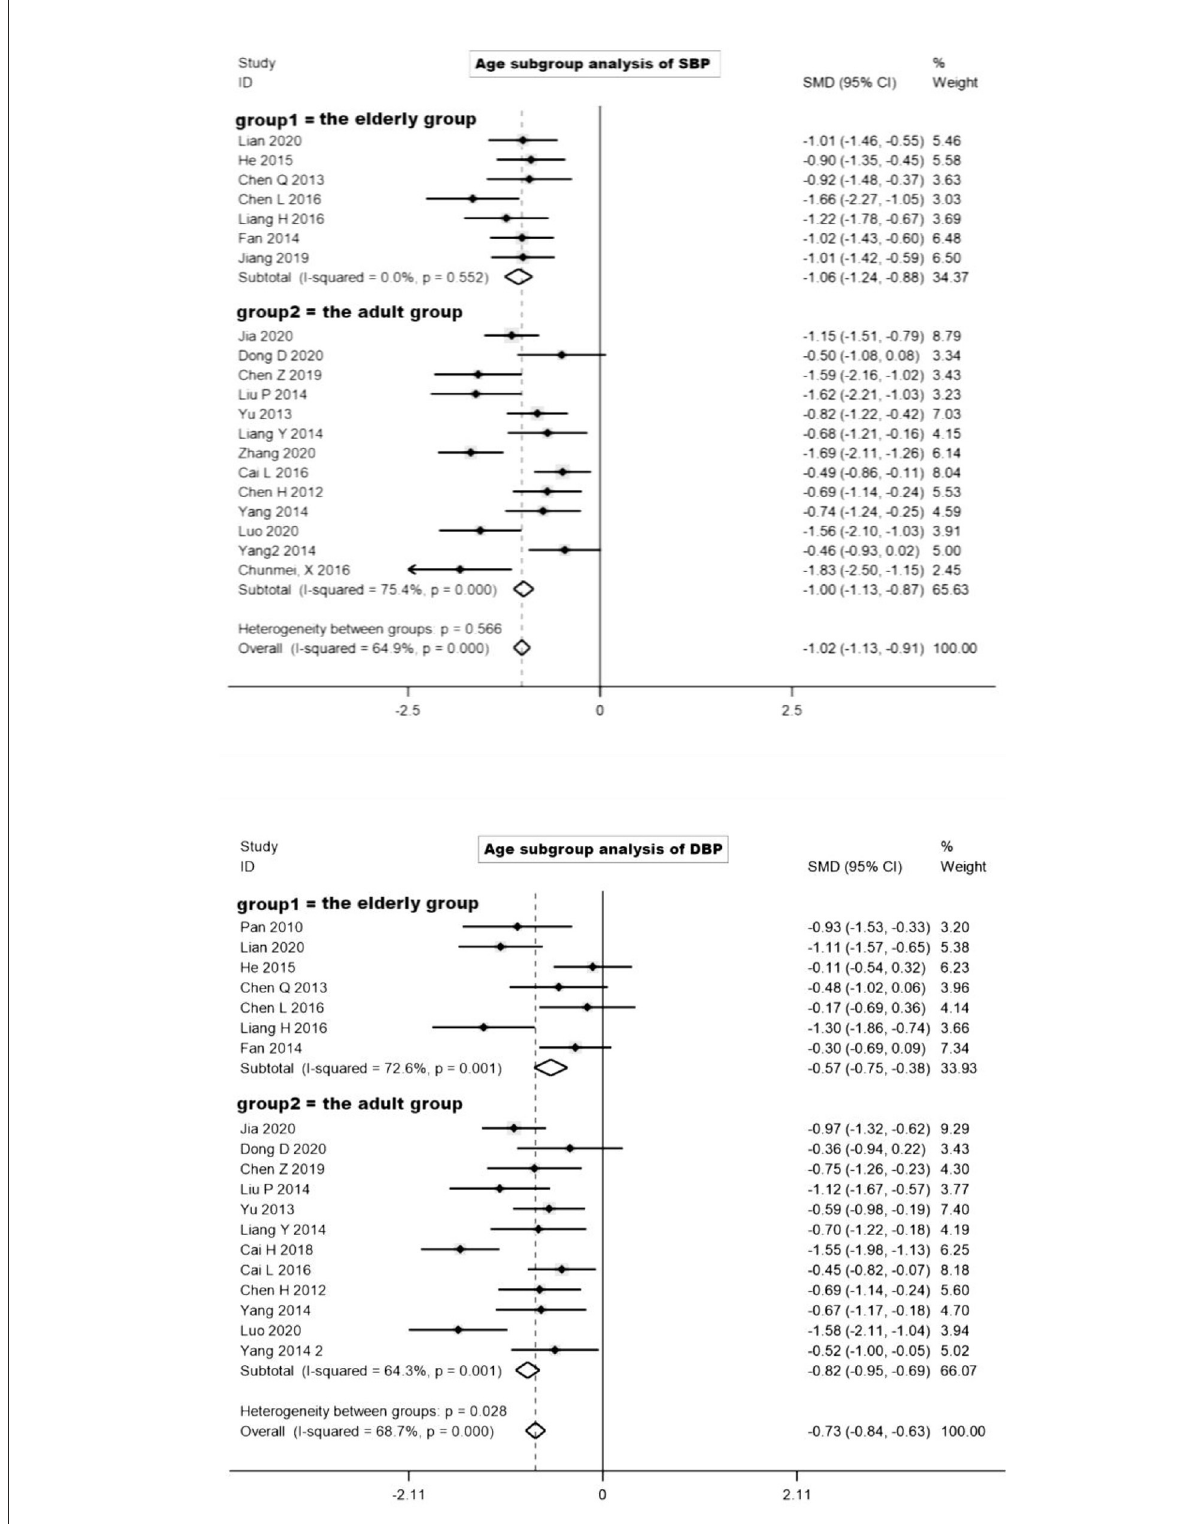
FIGURE3 Subgroup analysis of Baduanjin